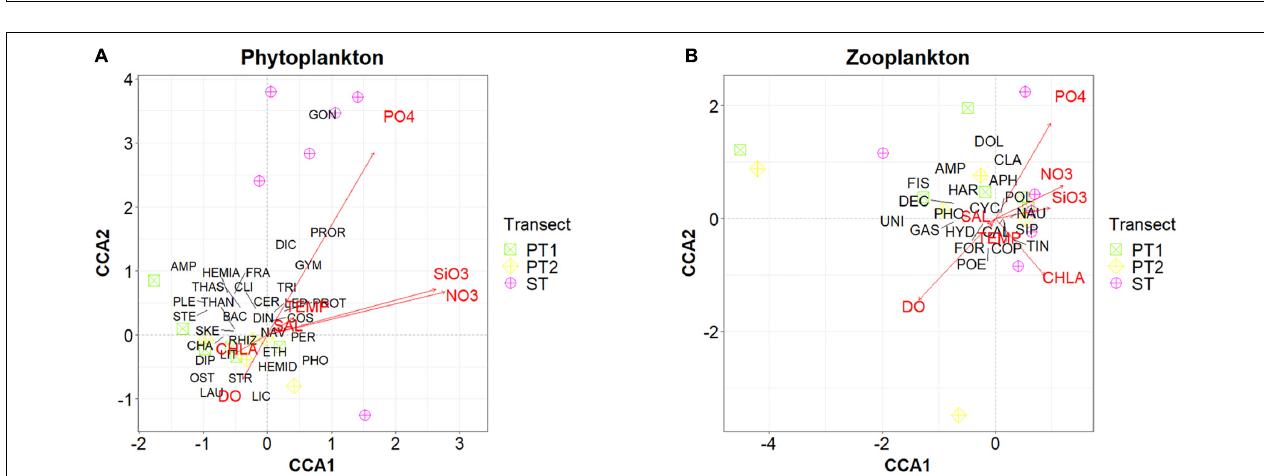
FIGURE 3 | Principal Coordinate Analysis of the stations based on phytoplankton (A) and zooplankton (B) assemblages. Transects are represented by different symbols, with the gray areas showing the dispersion of one transect. The colors of the symbols represent the reef zone.